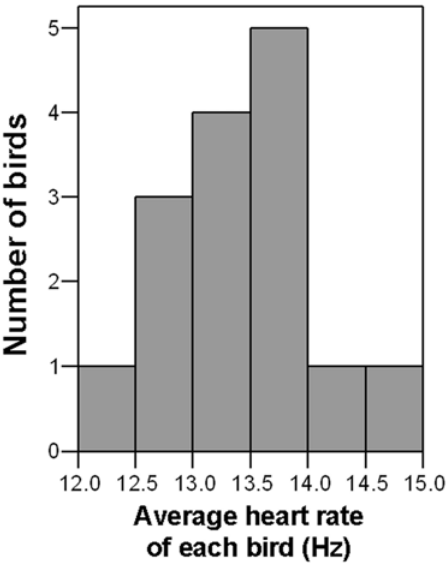
Figure 2. Frequency histogram for average heart rate. The graph shows the average heart rates (mean 6 s.e.m., 13.35 6 0.18 Hz) of 15 free- flying Swainson’s Thrushes migrating over the central United States in spring after initial ascent and prior to final descent. Note the large amount of variation. The histogram for the initial ascent phase (not shown) is virtually identical except the mean is higher: 14.43 6 0.16 Hz.